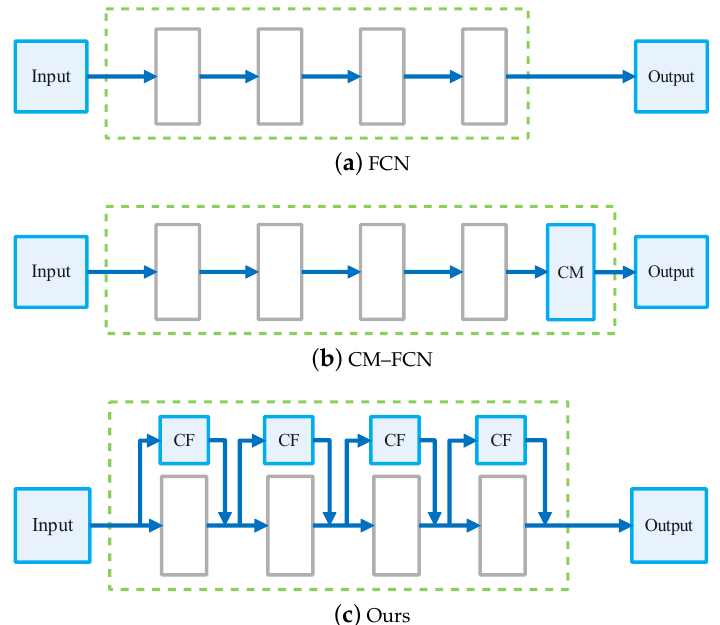
Figure 1. Common architectures for semantic segmentation. CM: contextual modules, CF: contextual features. ( a ) The FCN framework follows the guidelines of classification, which ignore contextual information. ( b ) CM–FCN model uses CM to extract contextual features of semantic information